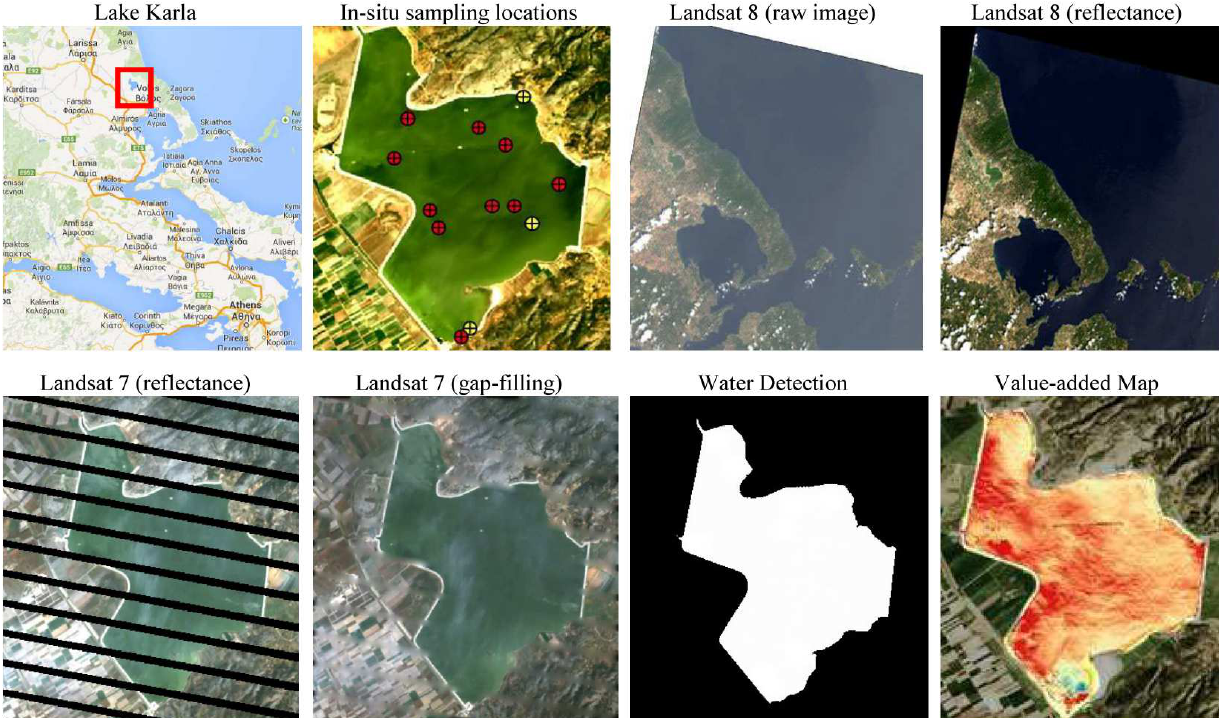
Figure 1: Lake Karla in central Greece was the study area. Several permanent (with yellow color) and non-permanent (with red color) sampling locations have been employed (top, second from left). Landsat 8 colour composites (RGB 432) before and after the radiometric and atmospheric corrections are, also, shown (top). An example of the processing procedure for the Landsat 7 datasets are presented (bottom). Landsat 7 images before and after the developed gap-filling algorithm are shown. The detected inland water in a binary format and the estimated map with dissolved oxygen concentrations are also demonstrated. Note that all the processing procedure is